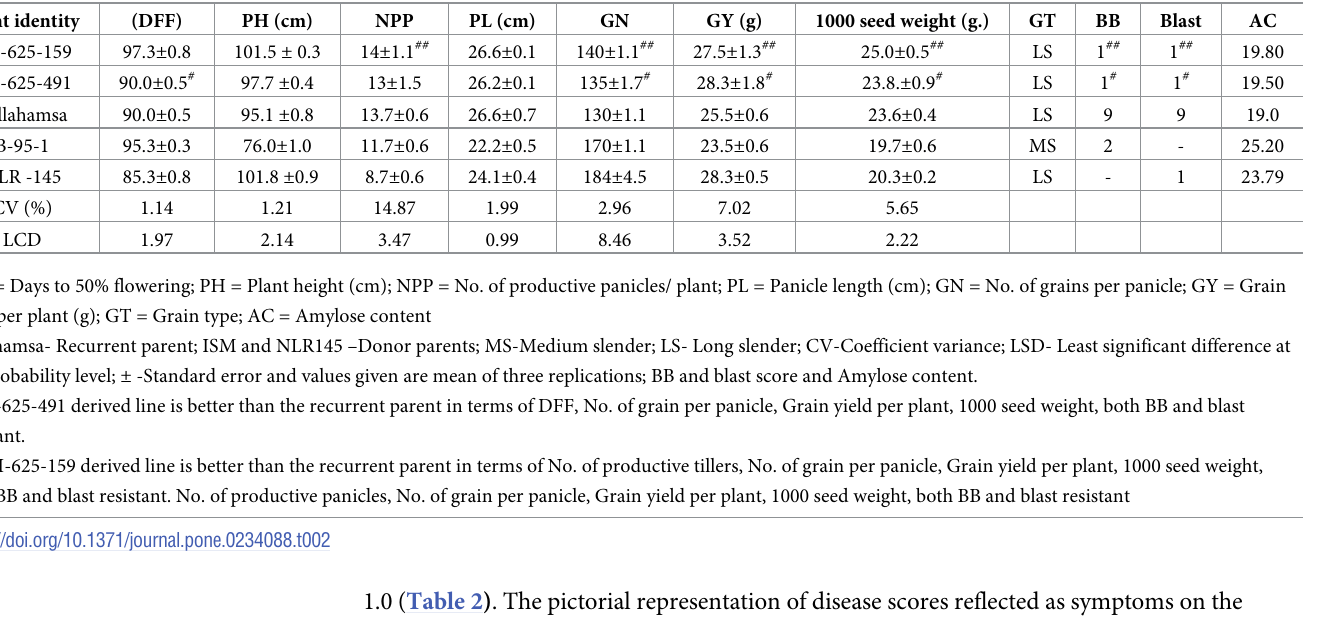
1.0 ( Table 2) . The pictorial representation of disease scores reflected as symptoms on the leaves has been given in Fig 3 . The complete process of screening of ICF lines along with 3 parents for BB and blast has been depicted in Fig 4A and Fig 4B respectively. Evaluation of ICF lines for yield and morpho-physiological traits 3 The ICF line derived from #TH-625-491 showed the days to 50% flowering (DFF) as well as 3 plant height data similar to recurrent parent (Tellahamsa) whereas line derived from #TH- 625-159 showed a 7 days late in DFF and was taller than recurrent parent (Fig 5A) (Table 2). The ICF line #TH-625-491 was found to be similar to the recurrent parent and had yield 3 advantage over the recurrent parent. However, both the ICF lines showed higher grain num- 3 ber per panicle (140, 135) as compared to Tellahamsa (130), thereby increase in yield per plant (28.3 gm, 27.5 gm) as compared to recurrent parent (25.5g) (Fig 5B). ICF lines also showed 3 grain type as similarity to the recurrent parent Tellahamsa (Fig 5C). Whereas the grain quality parameters, amylose content in the selected lines TH-625-159 (19.8%) and TH-625-491 (19.5%) was similar to recurrent parent (Tellahamsa) (19.0%) ( Table 2).